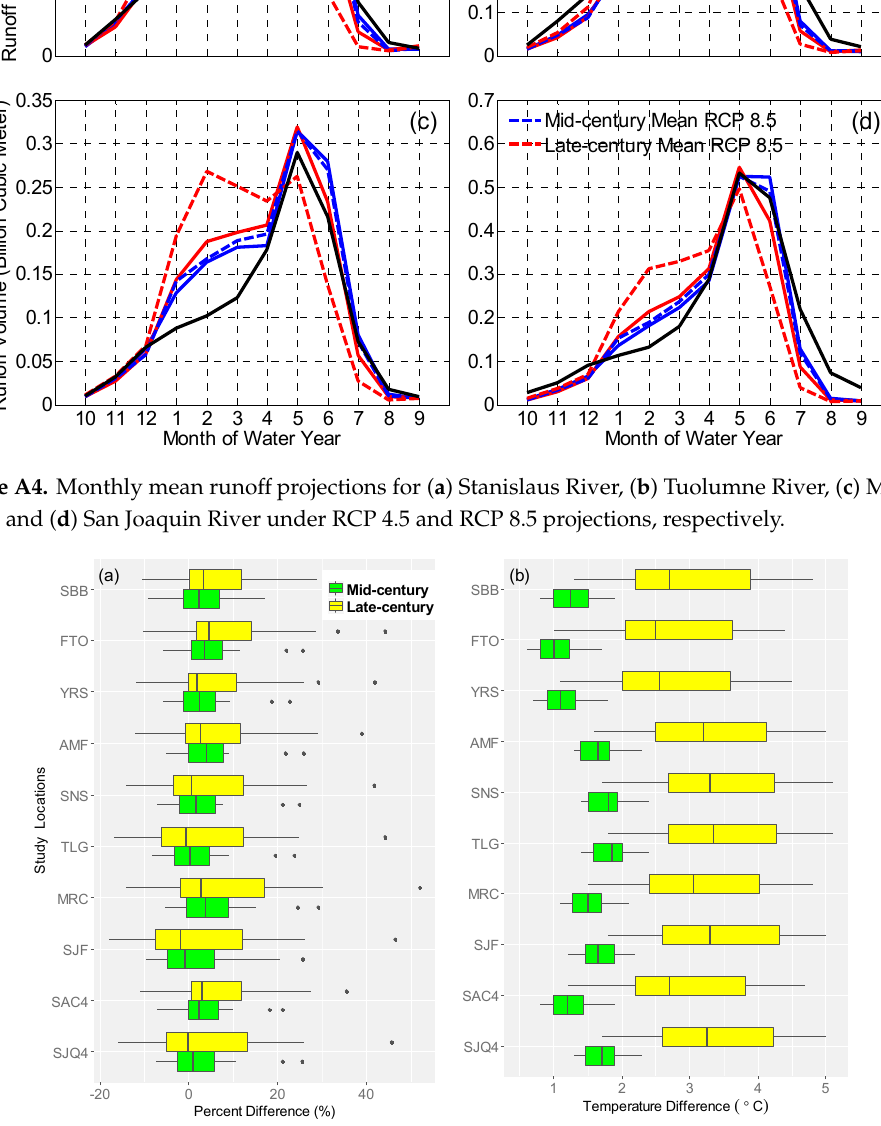
Figure A5. Box-and-whisker plots of ( a ) percent difference (%) between historical and 20 individual RCP 4.5 and RCP 8.5 projections on mean annual precipitation and ( b ) differences (°C) between historical and individual projections on mean annual temperature. Black dots designate outliers. Green boxes represent mid-century results and yellow boxes show late-century results.